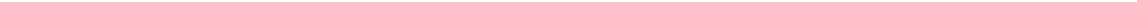
Fig. 3 PARP1 mediates PARPi sensitivity in BRCA1 mutant cell lines. a Cas9-expressing BRCA1 mutant SUM149 cells were transduced with PARP1-ZnF or hsvTK (non-targeting control) lentiviral sgRNA particles, selected in puromycin and exposed to the indicated talazoparib concentrations for 7 days. Representative SRB-stained 24-well plate image is shown. b Western blot showing PARP1 expression in talazoparib-resistant SUM149 clones TR1 and TR2. Par, parental SUM149 cells. TR2 has an in-frame PARP1-p.43_45delMFD mutation. c SUM149 clones TR1 and TR2 are highly talazoparib-resistant. Plot shows survival relative to DMSO-exposed cells after exposure to the indicated concentration of talazoparib for 7 days. Mean of fi ve replicates plotted, error bars show SD. d PARP1 mutant SUM149-TR2 xenografts do not respond to talazoparib treatment, whereas PARP1 wild-type SUM149 xenografts do. Top panels show Kaplan – Meier survival curves, with a tumour volume of 1000 mm 3 (after which mice were sacri fi ced) used as a surrogate end point. Lower panels show volume of individual tumours, normalised according to tumour volume on the day of randomisation (indicated by the arrow). e Pools of PARP1 guides cause talazoparib resistance in the BRCA1 mutant ovarian cancer cell line COV362. Cas9-expressing COV362 cells were transduced with the indicated lentiviral guide pool, selected in puromycin and assayed as in c . f Silencing of residual BRCA1 function, or BRCA2 , induces synthetic lethality with PARP1 genetic loss in SUM149 cells. B1.S* is a SUM149 derivative with a secondary BRCA1 mutation that confers PARP inhibitor resistance. SRB-stained 24- well plate image is shown, 7 days after siRNA transfection. g Colony forming assay using SUM149-Cas9 parental cells and the talazoparib-resistant daughter clone, TR2. Cells were transfected as in f , plated on 6-well plates and colonies stained and counted 2 weeks later. siRNA targeting BRCA1 or BRCA2 signi fi cantly reduces survival in PARP1 mutant cells (TR2) compared to the parental SUM149 line ( t -test). h BRCA1 and BRCA2 silencing is also synthetically lethal in COV362 PARP1 mutant clones A4 (p.119_120delKS) and D1 (p.848delY/YK). Colony formation assay as in g , p values for t -test shown. Mean of three replicates plotted, error bars show